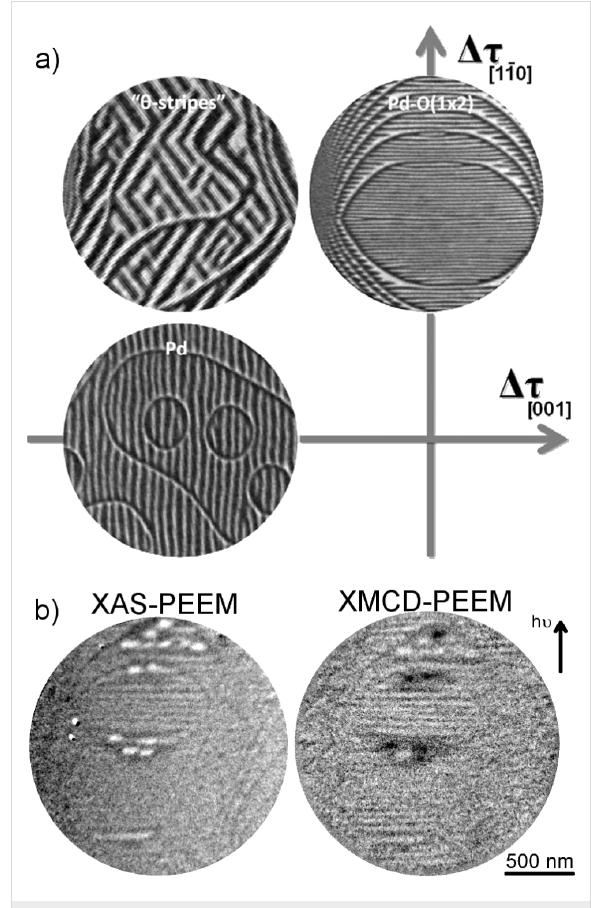
Figure 10: a) LEEM images (2 μ m diameter) of monolayer Pd stripes on W(110). The lower left panel shows Pd on a clean substrate, whereas the other two panels display the progressive change in pattern anisotropy upon addition of 0.1 ML and 0.33 ML oxygen. (Reprinted from [69]. Copyright 2011 IOP Publishing.) b) Fe grown on Pd–O stripes at 225 °C. Left panel is the XAS-PEEM image at the Fe L 3 edge showing the Fe distribution. On the right, the Fe XMCD image indicates that the wires are uniformly magnetized perpendicular to the long axis. (Reprinted from [70]. Copyright 2013